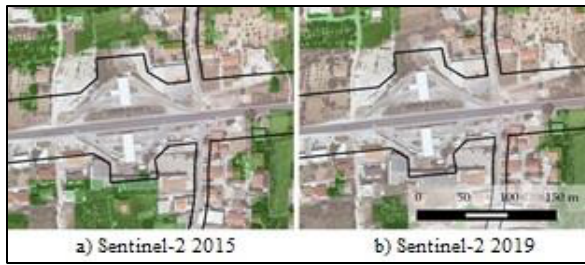
Figure 11. A closer look at classification results in the commercial area - green areas show land under